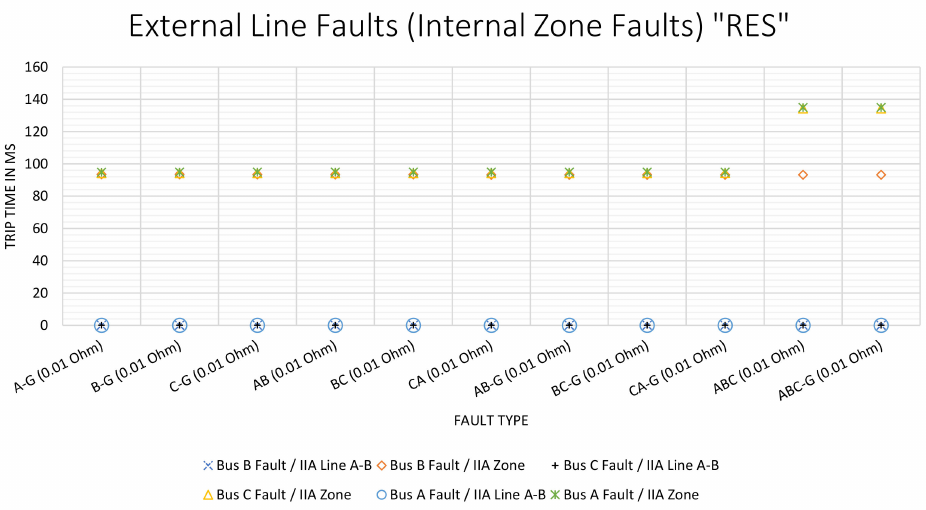
Figure 14. Results for external line faults tests, Side B with